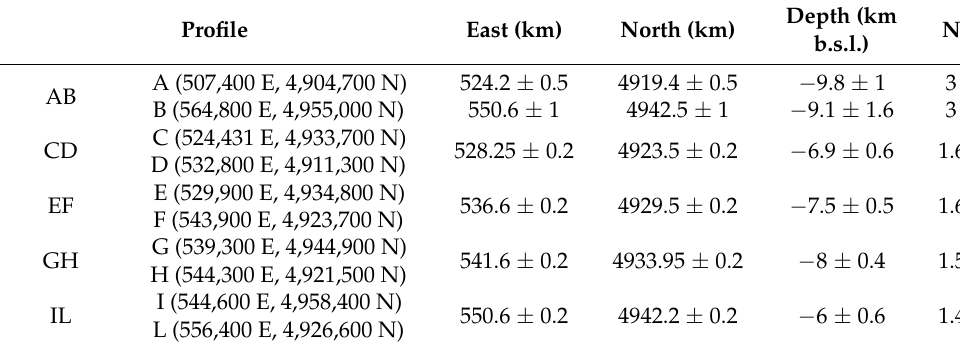
Table 2. Results of multiscale methods at Yellowstone